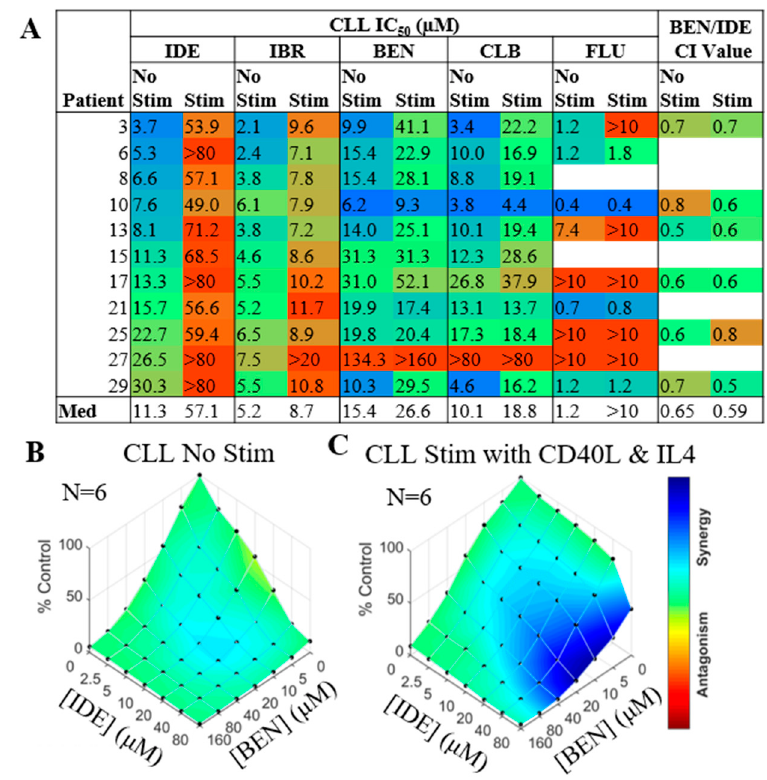
Figure 3. Enhanced synergy occurs between idelalisib (IDE) and bendamustine (BEN) when the microenvironment is simulated by the addition of CD40L and interleukin 4 (IL4). Cell death was measured 72 h post drug treatment. ( A ) Table showing di ff erences in response of primary chronic lymphocytic leukemia (CLL) samples to single agent drugs (blue—sensitivity, red—resistance) or BEN / IDE combination index (CI) value at clinically relevant concentrations (blue—synergy, green—additivity and, red—antagonism) with or without stimulation. ( B , C ) Combenefit synergy plots combining BEN and IDE in 6 primary CLL patient cells without ( A ) or with ( B ) stimulation with CD40L / IL4. Blue—synergy, green—additivity and, red—antagonism. 2.2. IDE and BEN Are Also Synergistic in Normal B Cells but Not T Cells